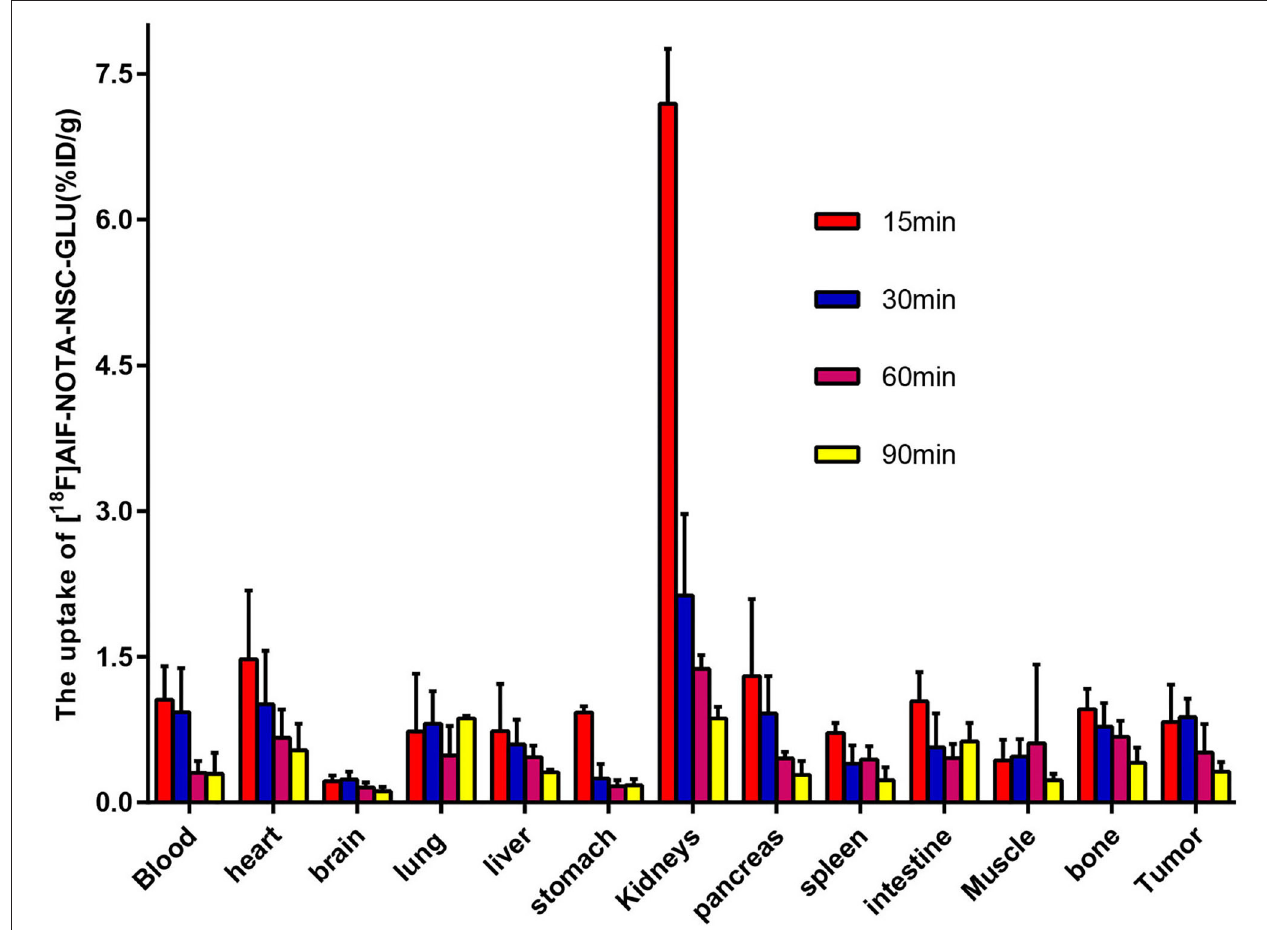
FIGURE 2 | Biodistribution of [ 18 F]AlF-NOTA-NSC-GLU in tumor-bearing